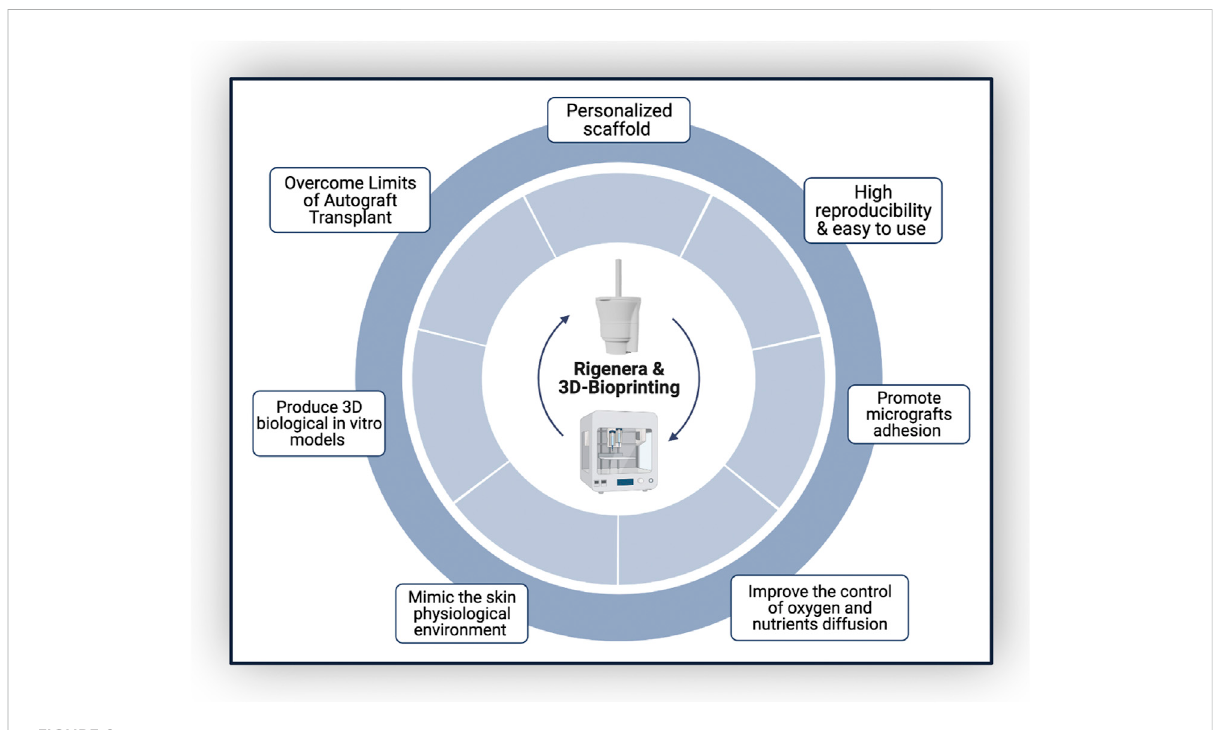
FIGURE 2 Applicability and suitability of the Rigenera ® technology with 3D